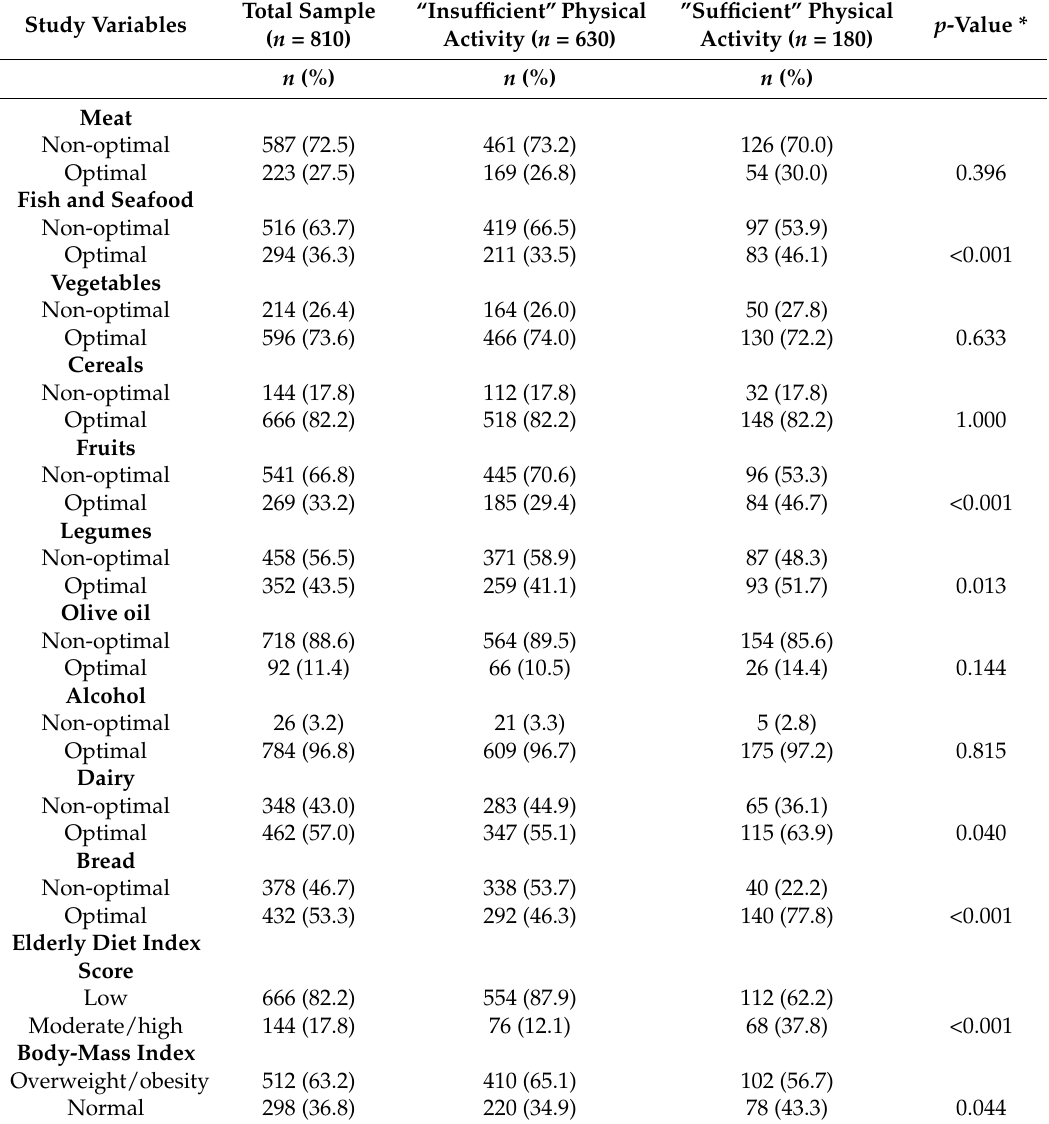
Table 2. Basic descriptive statistics of the study participants; Croatia ( n =